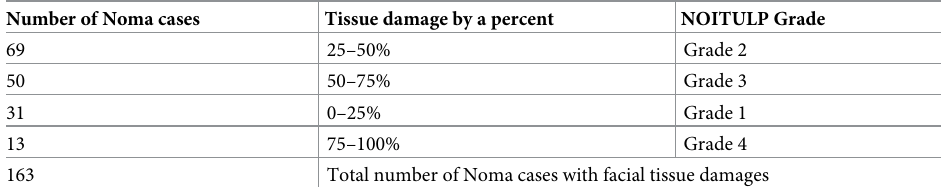
Table 2. Noma cases with different levels of facial tissue damages (NOITULP